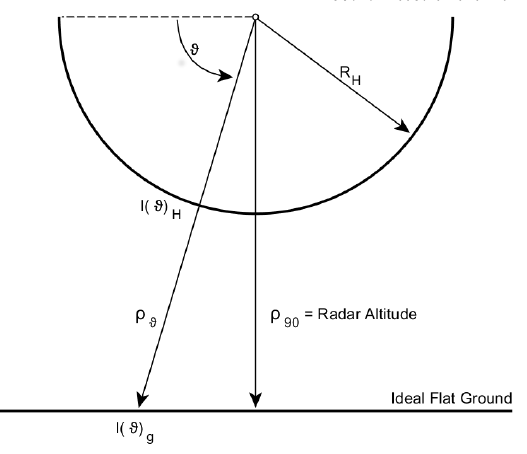
Figure 30: SPL radiation from the back-rotated hemispherical grid to the ideal flat ground.